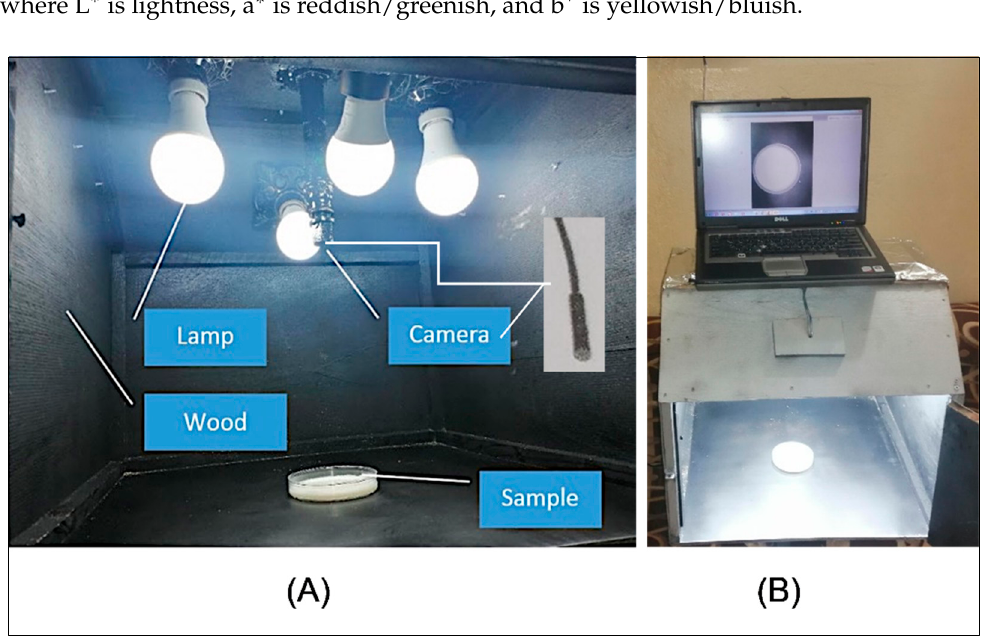
Figure 2. The image acquisition system applied in the current study ( A ): inside view of the system; ( B ): outside view of system.